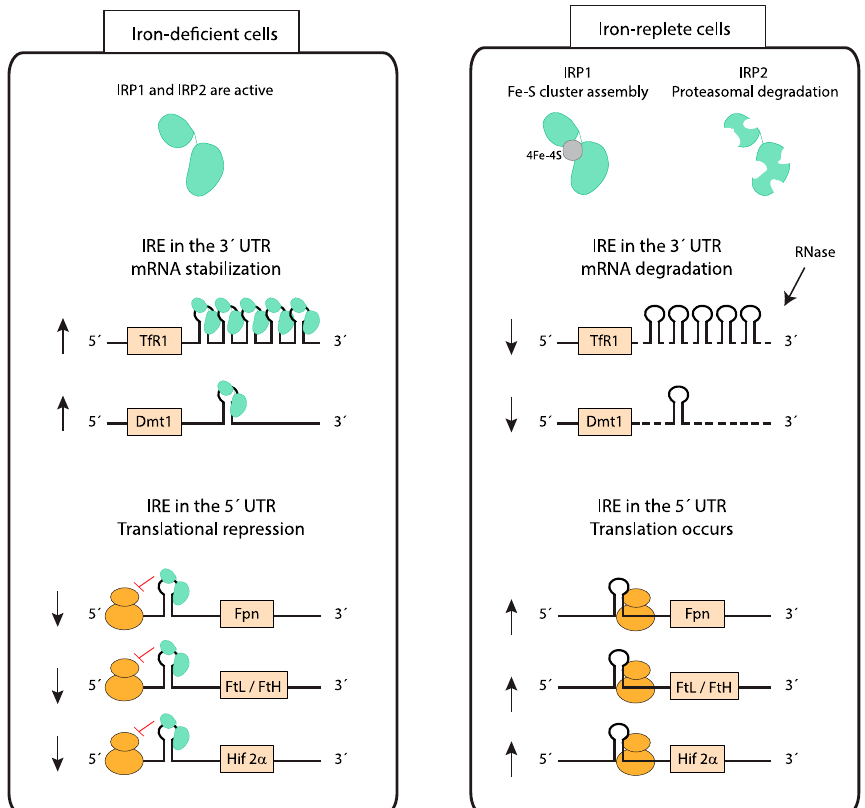
Figure 3. Cellular iron homeostasis: iron responsive element (IRE)/ iron regulatory protein (IRP) system. IRP1 and IRP2 bind to IREs present in either the 5’ untranslated regions (UTR) or 3’ UTR of mRNAs and regulate their translation and stability, respectively. In iron-depleted cells, IRPs bind to an IRE localized in the 5’ UTR of mRNAs to repress translation, while IRP binding to IREs in the 3’ UTR stabilizes mRNAs. In iron-replete cells, IRP1 switches from its IRE-binding form to a Fe-S cluster containing aconitase and IRP2 is degraded. The lack of IRP binding to IREs allows for the translation of mRNAs containing an IRE in the 5’ UTR and degradation of mRNAs containing IREs in the 3’ UTR. This mechanism counterbalances both cellular iron deficiency and iron overload. (Fpn—ferroportin; FtL—ferritin light chain; FtH—ferritin heavy chain; HIF-2 α —hypoxia-inducible factor-2 α ).